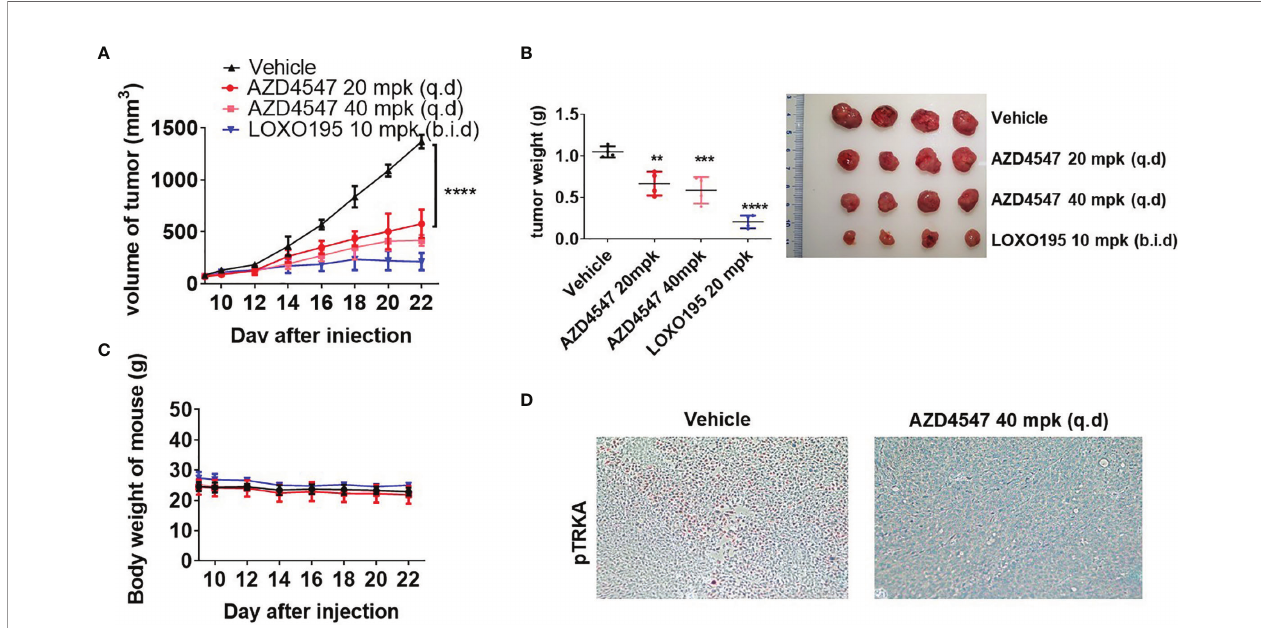
FIGURE 5 | In vivo ef fi cacy of AZD4547 in the KM12(Luc) xenograft model. (A) AZD4547 treatment signi fi cantly delayed tumor growth. KM12(Luc) implanted mice were administered by oral gavage (p.o, q.d for vehicle and AZD4547, b.i.d for LOXO195) with the indicated dosage (n = 4, Allow indicates the administration starting day. Tukey ’ s multiple comparisons test, **** < 0.0001). Tumor volume (mm 3 ) was measured once every 2 d. Data was plotted as mean ± SD (n=4) (B) Tumor weight was measured at the end of the experiment. (Dunnett ’ s multiple comparisons test, ** < 0.005, *** < 0.001, **** < 0.0001) (C) Body weight was monitored during